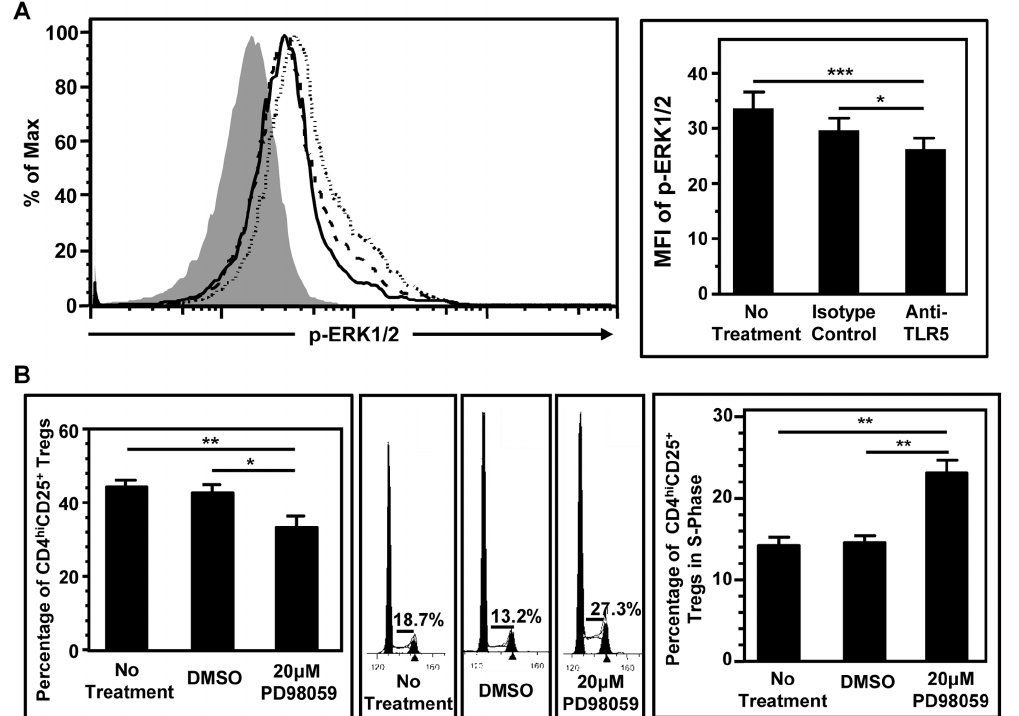
Figure 3. Reduced phosphorylated ERK1/2 might contribute to S phase arrest in CD4 hi CD25 + regulatory T cells. (A) Flow cytometric analysis of the expression of phosphorylated ERK1/2 in CD4 hi CD25 + regulatory T cells generated with no treatment (dotted line), isotype-matched mAb (dashed line), and with anti-TLR5 blocking mAb (solid line). Filled histogram is the staining obtained from isotype-matched mAb control for staining antibody (left panel). Statistical analysis of the MFI of p-ERK1/2 in CD4 hi CD25 + regulatory T cells. Data show Mean + SEM, n =10. All data shown are representative from five independent experiments (right panel). (B) Statistical analysis of the percentage of CD4 hi CD25 + regulatory T cells generated on Day 6 with or without the inhibition of ERK1/2 phosphorylation by PD98059. DMSO treated group is the control for PD98059. Data show Mean + SEM, n =6. All results shown are from 3 independent experiments (left panel). Cell cycle analysis of CD4 hi CD25 + regulatory T cells generated on Day 6 with or without the inhibition of ERK1/2 phosphorylation by PD98059. DMSO treated group is the control for PD98059. Numbers indicate the percentage of CD4 hi CD25 + regulatory T cells in S phase. All results shown are from 3 independent experiments (middle panel). Mean percentage of CD4 hi CD25 + regulatory T cells in S phase with the inhibition of ERK1/2 phosphorylation by PD98059. Data show Mean + SEM, n =6. All results shown are from 3 independent experiments (right panel). * p , 0.05, ** p , 0.01, *** p , 0.001, one way ANOVA with Tukey’s pairwise